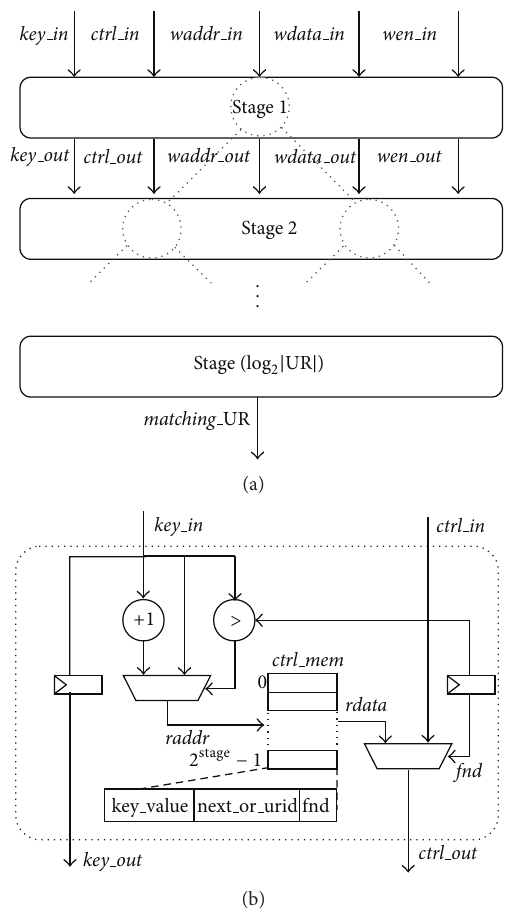
Figure 13: Binary decision tree: (a) tree architecture and (b) node architecture (1